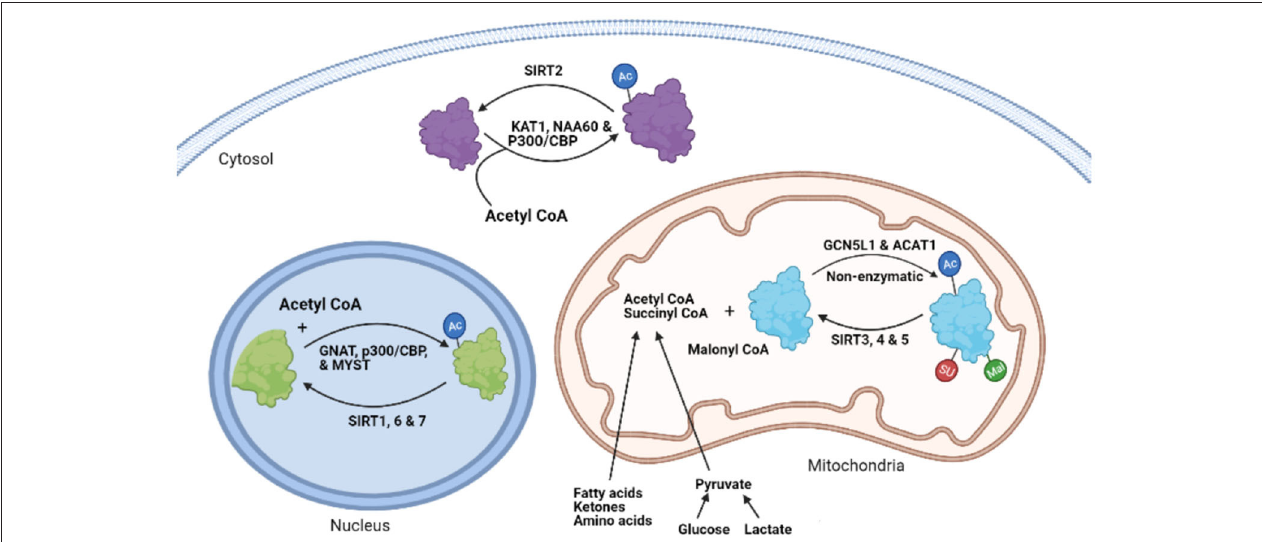
FIGURE 1 | The process of protein lysine acetylation/acylation and deacetylation/deacylation. KAT1, lysine acetyltransferase; NAA60, N- α -acetyltransferase 60; CBP, CREB-binding protein; SIRT, sirtuin, GNAT, GCN5-related N-acetyltransferases; MYST, MYST family acetyltransferase; GCN5L1, General control of amino acid synthesis 5 (GCN5) like-1; ACAT1, acetyl-CoA acetyltransferase; AC, lysine Acetylation; SU, succinylation; MU,